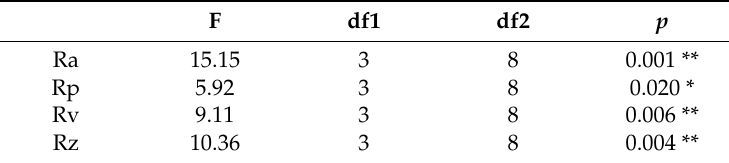
Table 5. One-Way ANOVA